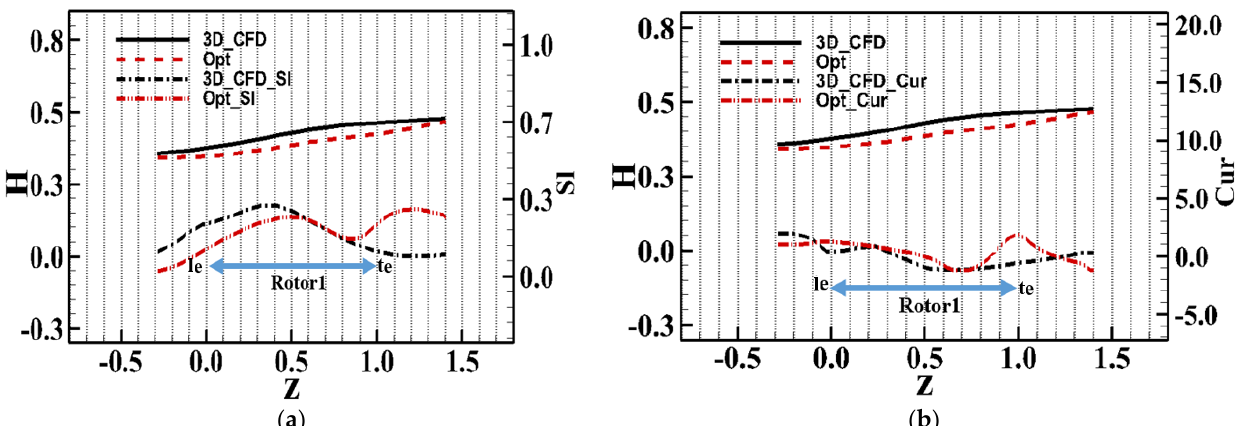
Figure 16. The slope and curvature of the hub in the rotor1 interval. ( a ) The slope of the hub; ( b ) The curvature of the hub.